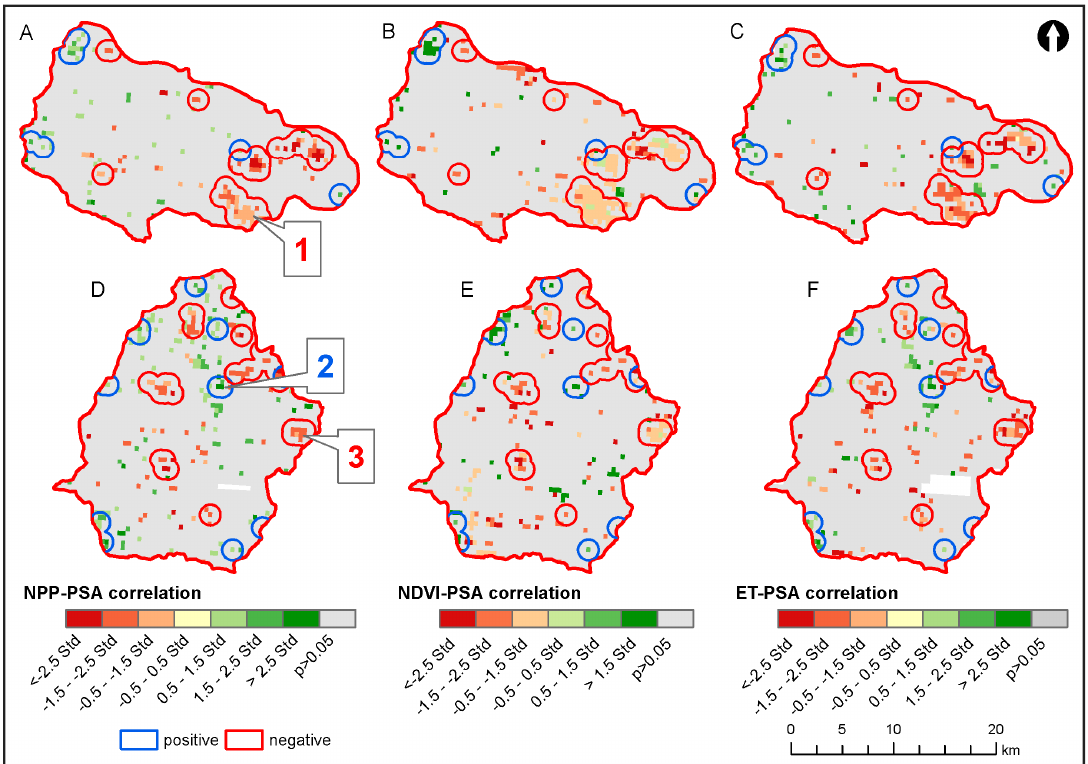
Figure 5. Spatial distribution of albedo correlation with NPP, NDVI and ET.